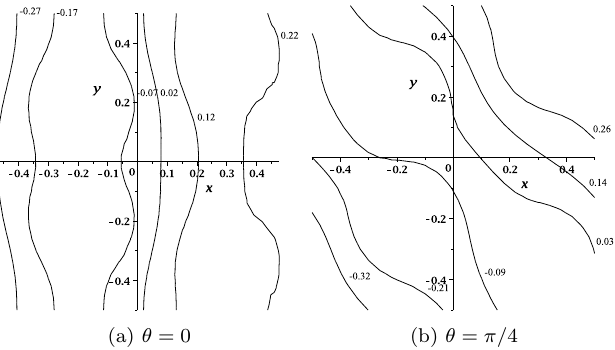
Figure 6. The temperature distribution inside Q (0 , 0) for λ k = 100, γ k = 100, β k = − 100, θ = 0; π/ 4.